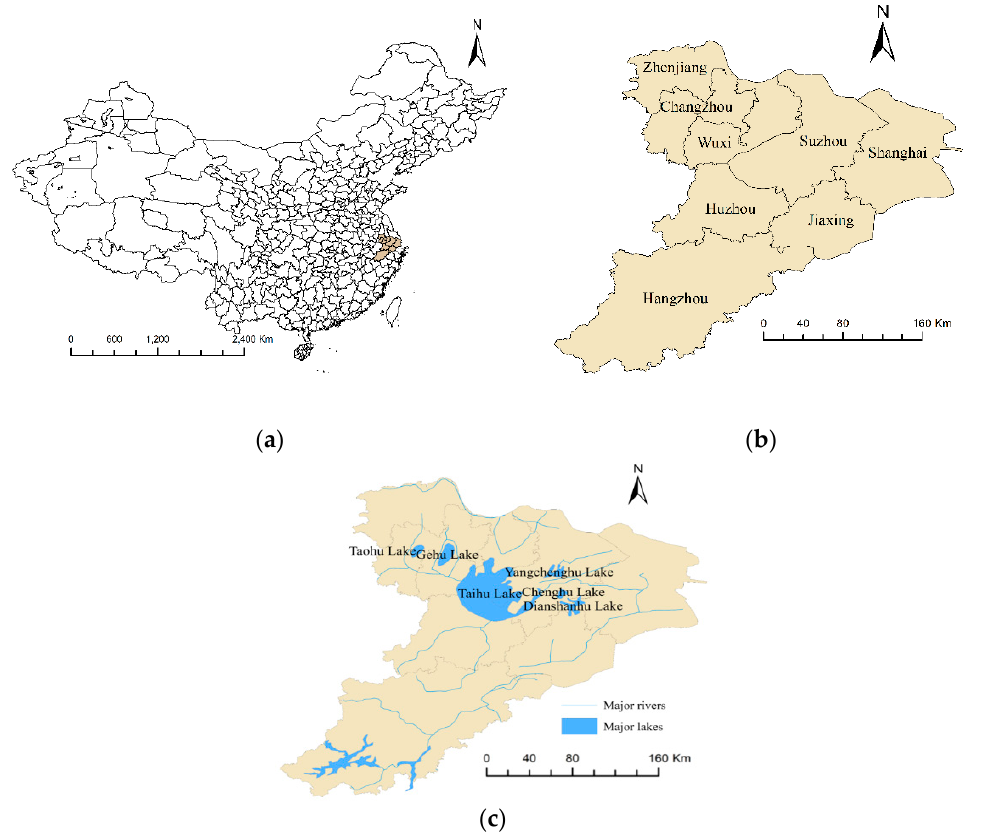
Figure 3. Schematic diagram of the study area delineated in this study. ( a ) The location of Taihu basin in China. ( b ) The study area of Taihu basin. ( c ) Distribution of main lakes and rivers in Taihu basin